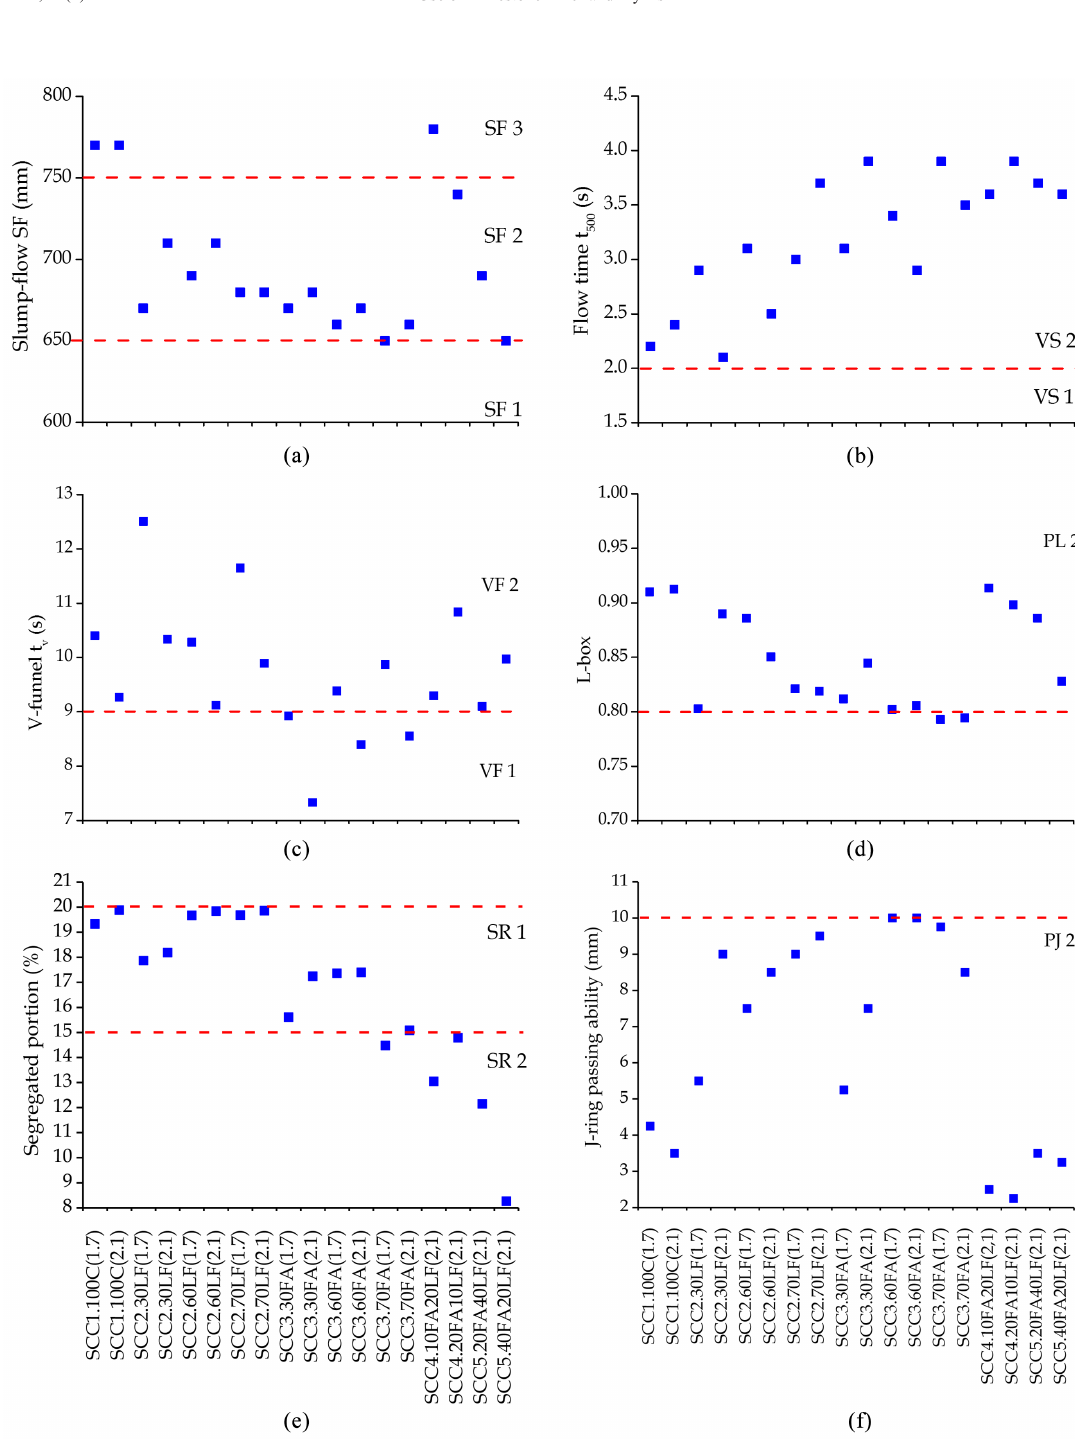
), V-funnel (t ), L-box (H /H ), Segregation and J-ring (passing ability) tests 500 v 2 1